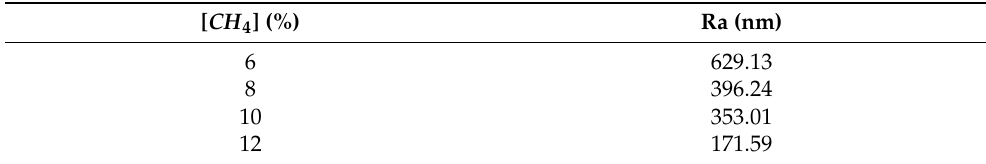
Figure 7. Profilometry of the surface of samples grown with ( a ) 6% ( b ) 8% ( c ) 10%, and ( d ) 12% CH 4 . Table 3. Collected data of surface Ra for each sample.